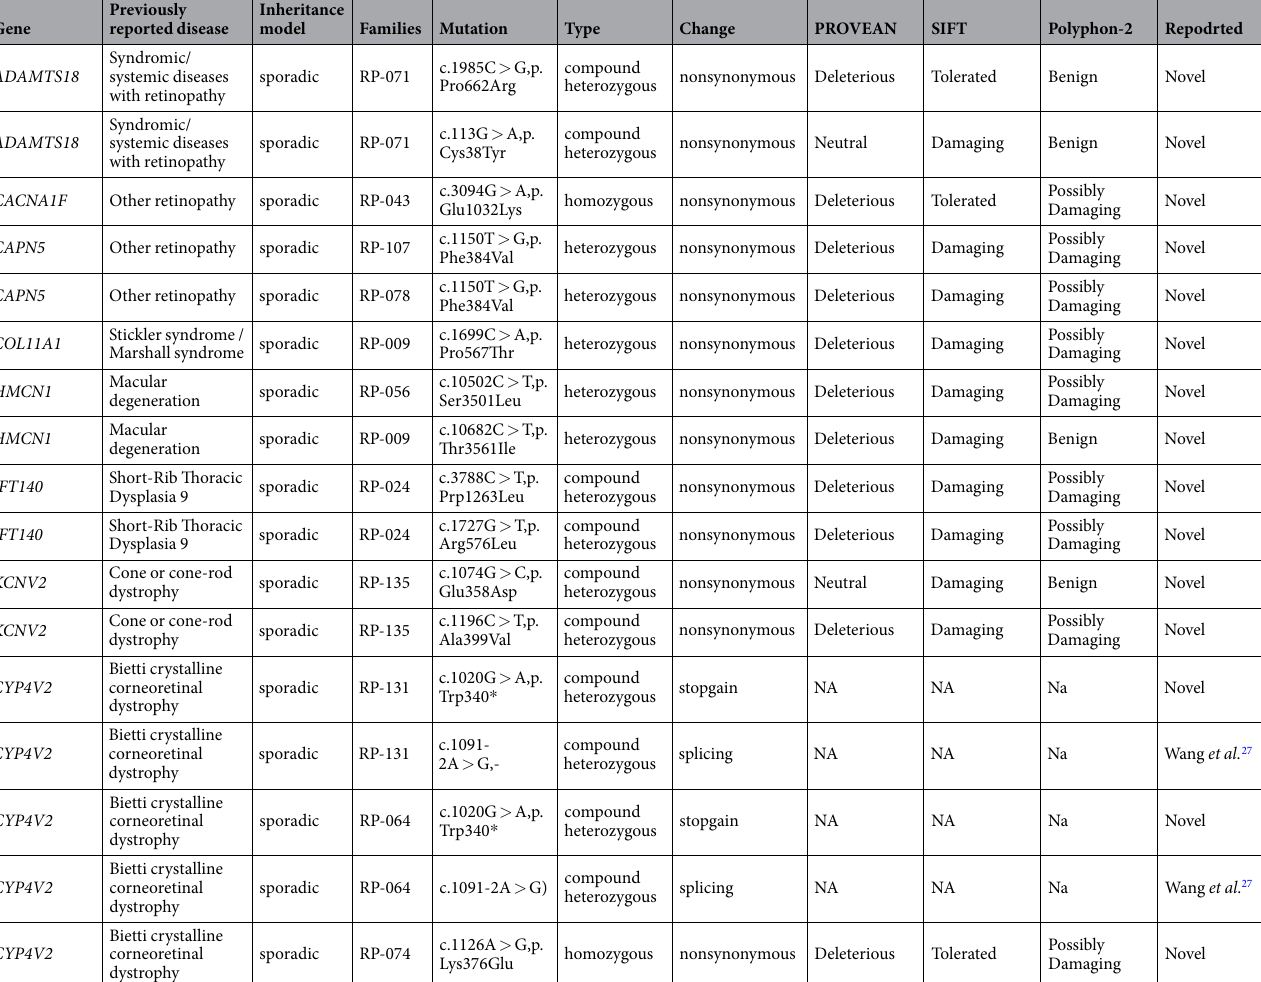
Table 3. Fourteen potential mutations from 161 genes associated with other forms of retinopathy in the RetNet database in the 11 of the 98 small Han Chinese families with RP. The mutations were filtered with the following multiple-step bioinformatics analysis: (1) the SNPs and short indels in the exome region were filtered against data from 1000 genome, dbSNP135-common, ExAC and unrelated individuals of 2020 in-house non-RP controls, removing minor allele frequency (MAF) values that were greater than 0.005 for recessive model and any frequency for dominant model; (2) excluded non-coding variants without altering splicing sites; (3) excluded the synonymous variants without altering splicing sites in the genes; 4) excluded missense variants predicted to be Neutral/Tolerated /Benign by PROVEAN, SIFT and